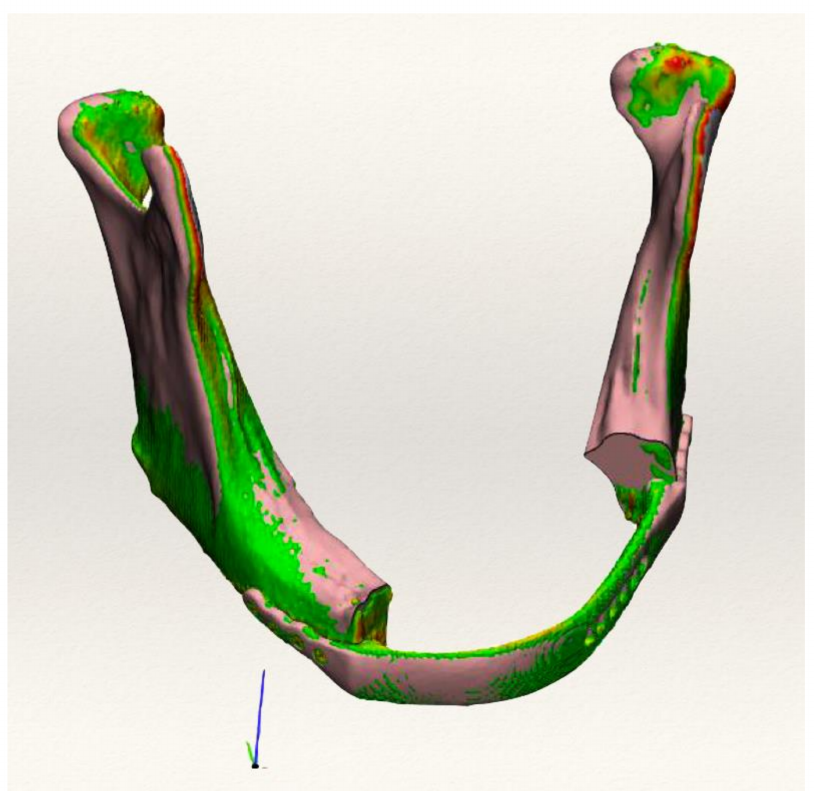
Figure 4. Superimposition of planning and post-operative CT scan obtaining a color map.